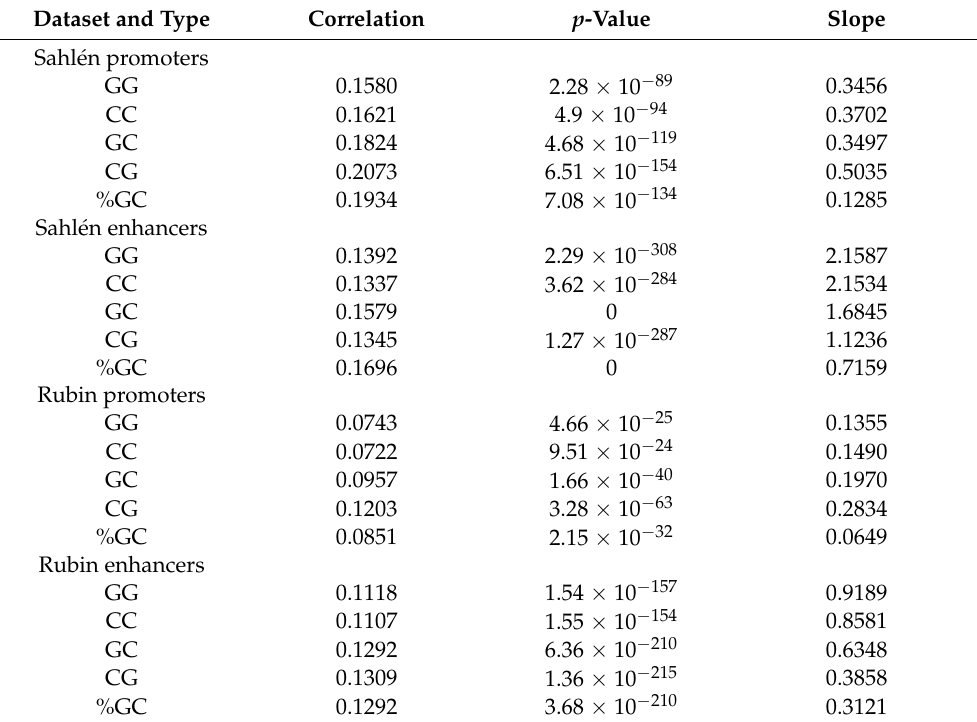
Table 1. Correlation of node degree with the GC content and the counts of (G or C) dinucleotides. Dataset and Type Correlation p -Value